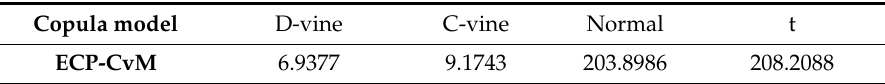
Table 4. Comparison of ECP-CvMs of three copula models.